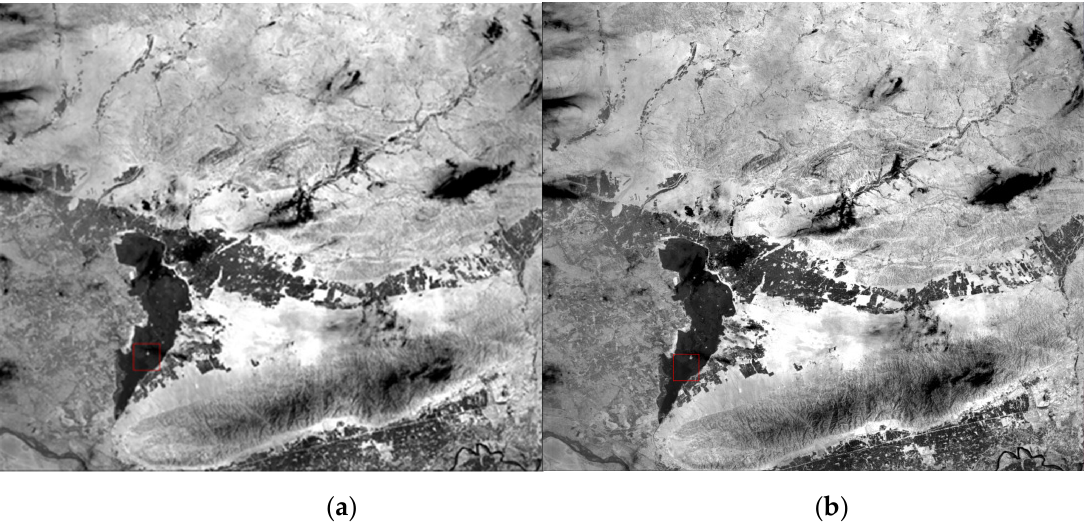
Figure 12. Thermal infrared image data for Ulansuhai Nur (10 July 2022), including ( a ) sensor1 and ( b ) sensor2.